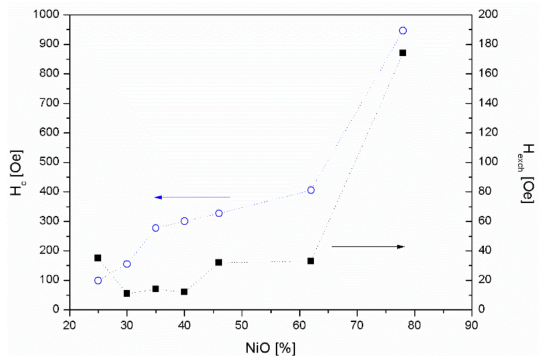
Figure 6. Coercivity H C and exchange bias H EB of NiO/Ni composite particles as a function of relative fraction of